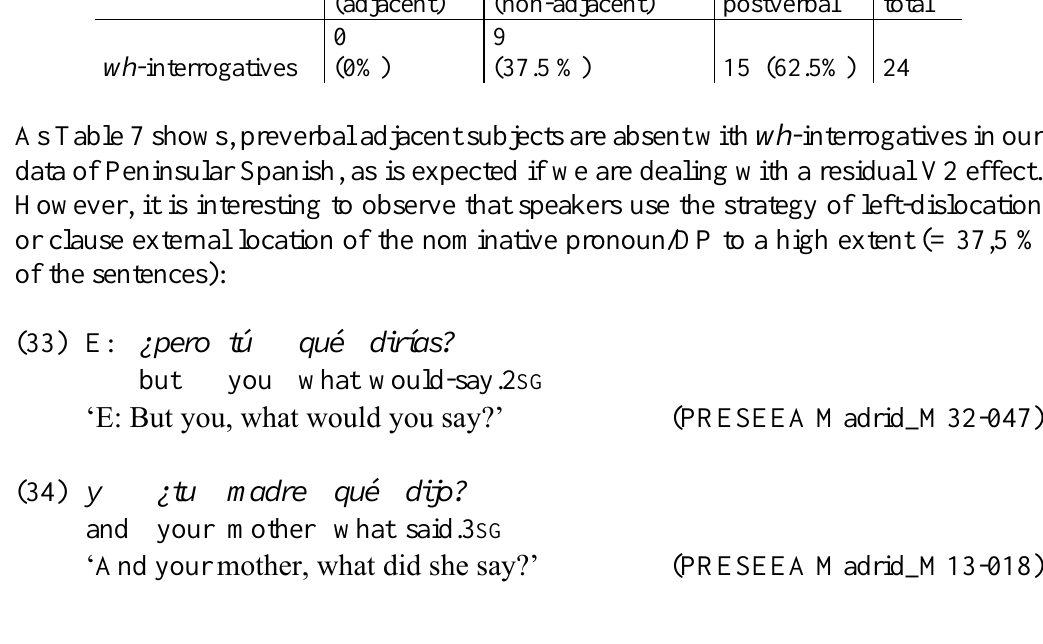
Table 7. Subject position in wh -interrogatives with decir preverbal